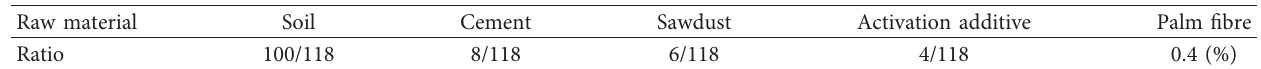
Table 1: The raw material ratio.